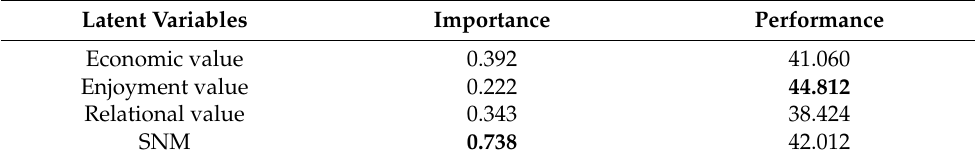
Table 7. Importance-performance map analysis.